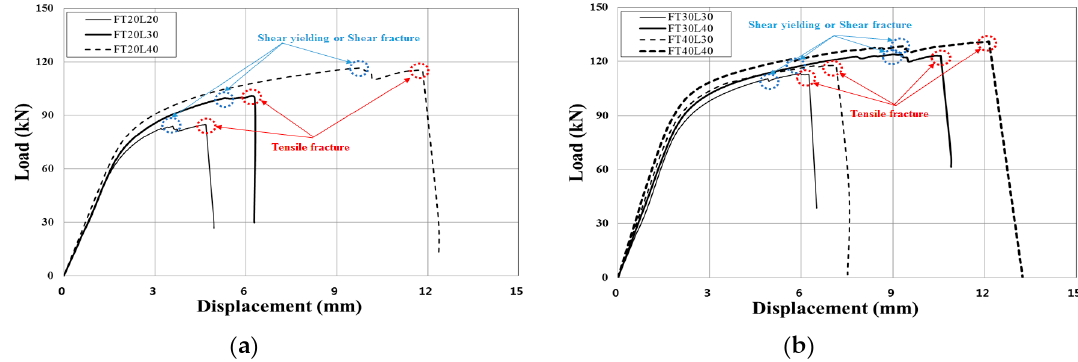
Figure 2. Load-displacement curves of specimens: ( a ) FT20 series and ( b ) FT30 series and FT40 series.